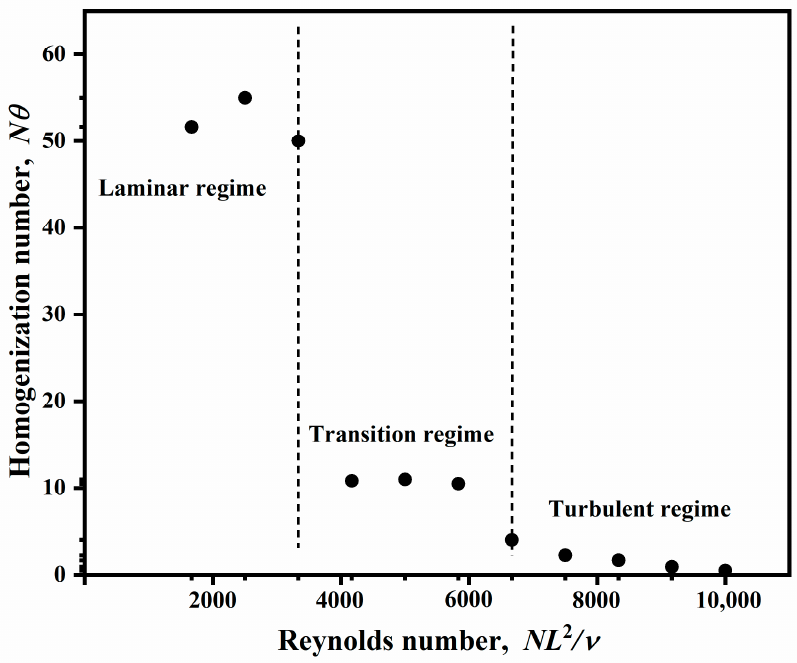
Figure 3. Relationship between Reynolds number and homogenization number.